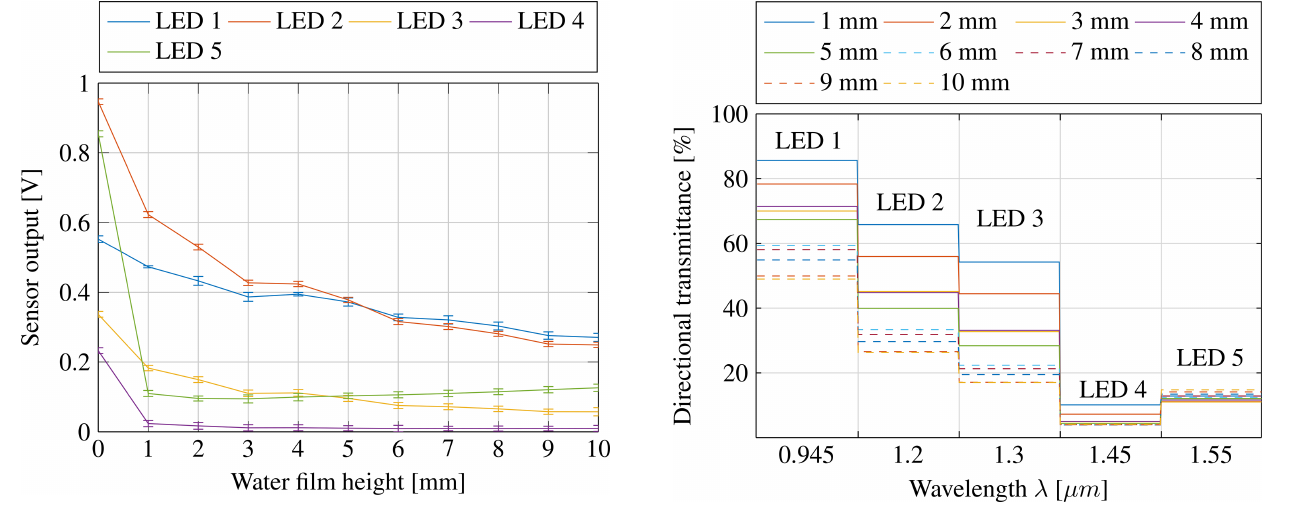
Figure 10. Measured directional transmittance for increasing water film heights from 1 to 10mm with white tile surface at a distance of